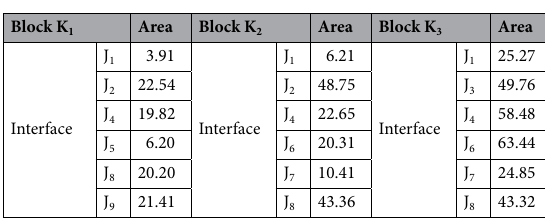
Table 4. Area of block interfaces.